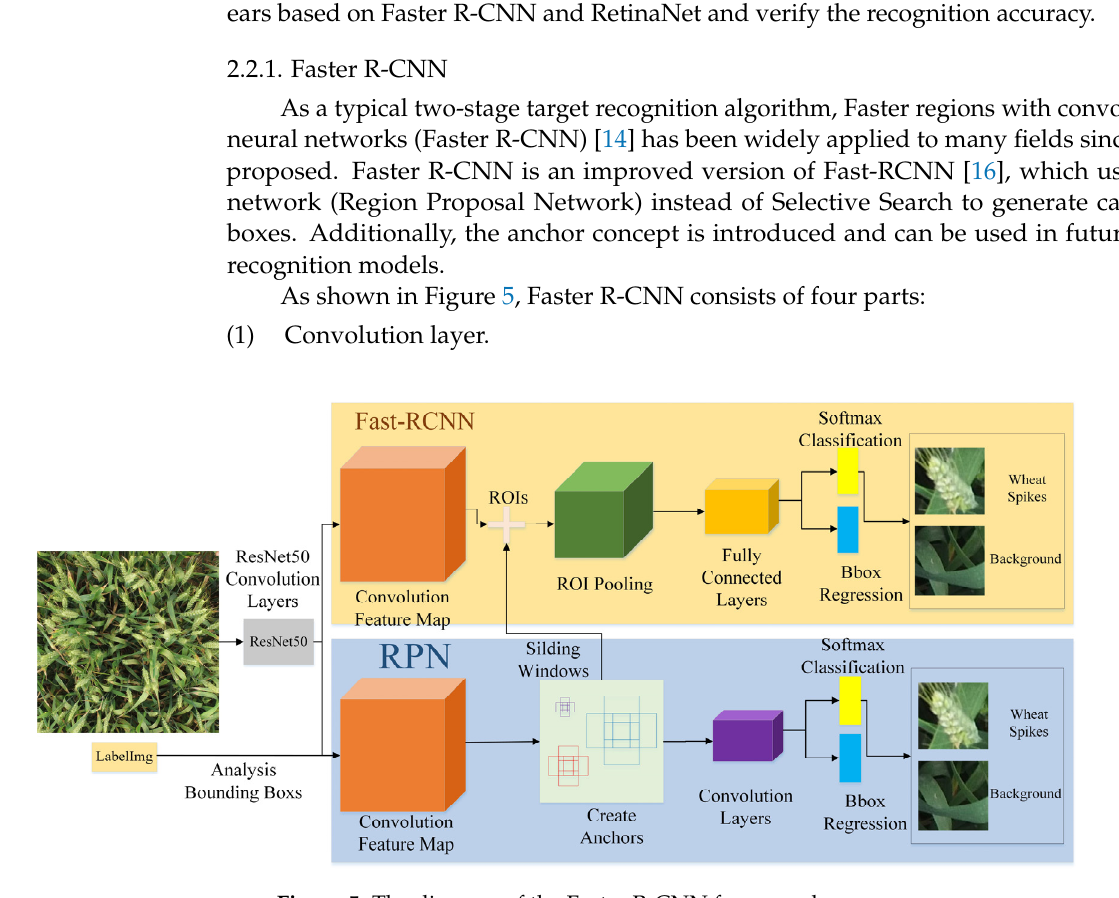
Figure 5. The diagram of the Faster R-CNN framework.